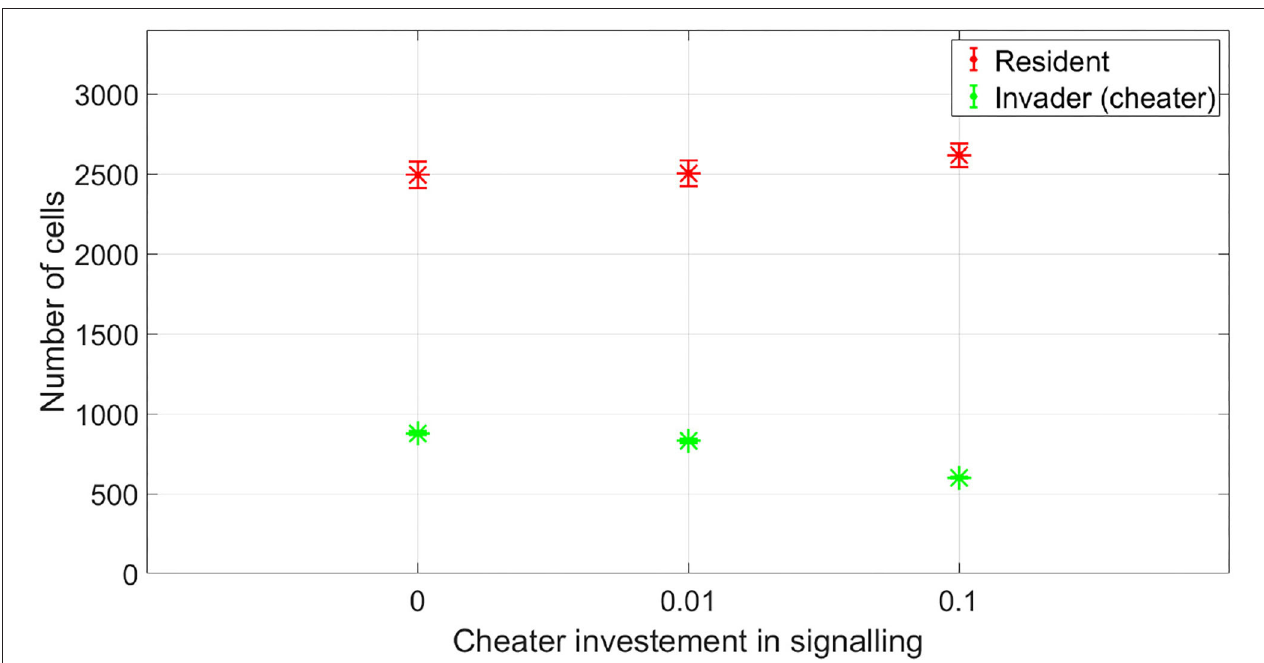
FIGURE 10 | The fitness of a non-efficient antibiotic producer vs. a resident species, when the resident species adopts a competition tolerance strategy at a high subinhibitory antibiotic concentration. By setting a high signal threshold, the resident species avoid abusing its competition tolerance response by weak opponents. Here, the cost incurred by the non-efficient antibiotic producer to activate the competition tolerance response is higher than the potential gain. The data representation is the same as Figure 4 .